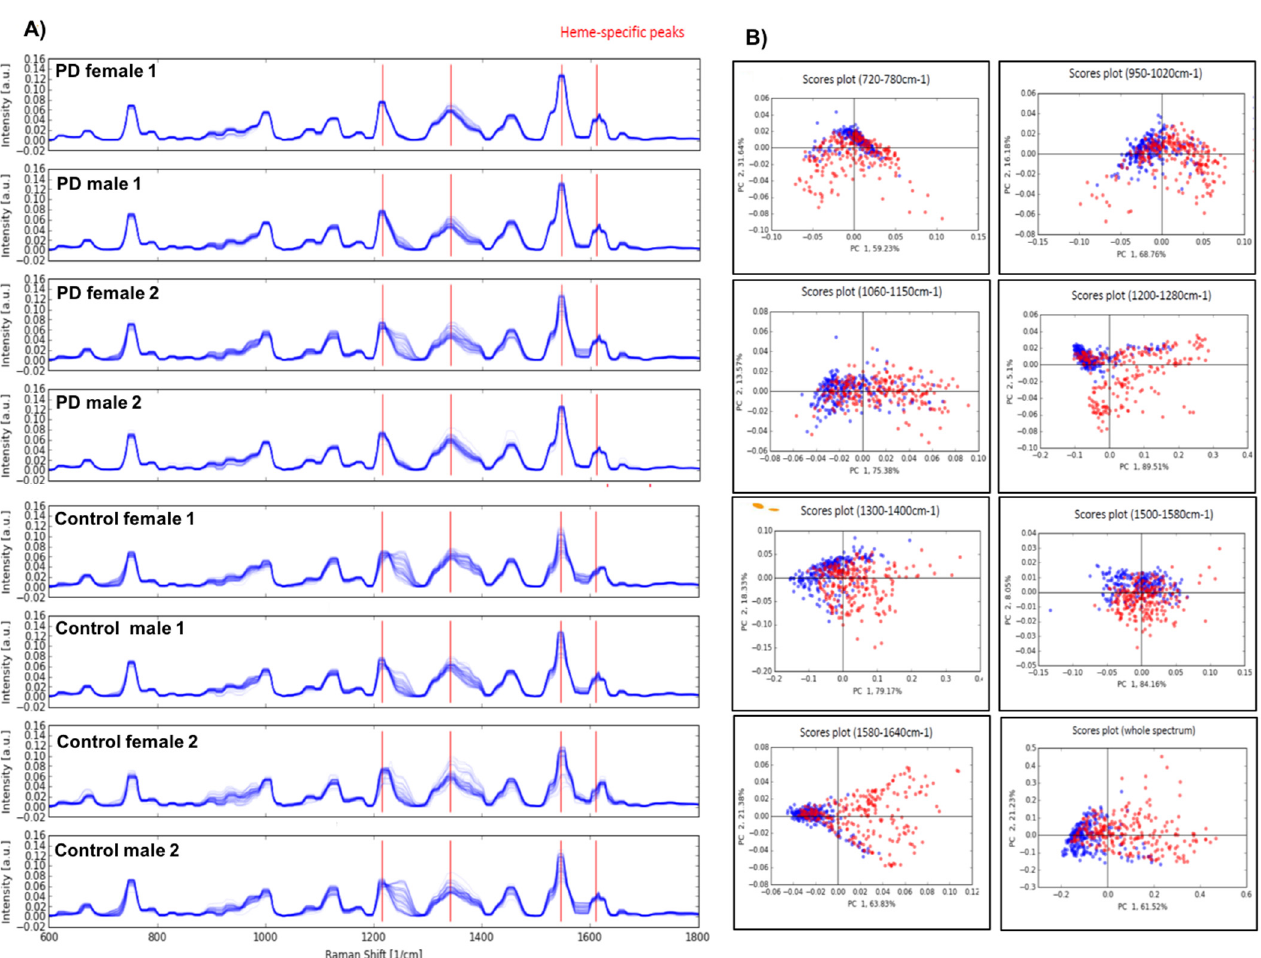
Figure 1. Raman spectroscopy of erythrocytes in PD. ( A ) Raman spectroscopy on the blood samples showed overall similar peaks constituting the spectrum, however internal variance in PD samples can be seen, which might be due to the disease-specific heterogeneity of single red blood cells. ( B ) Principal component analysis (PCA) clearly demonstrated that the Raman signal intensity at 1260 and 1545 cm − 1 had the biggest correlation to the patient’s disease status.